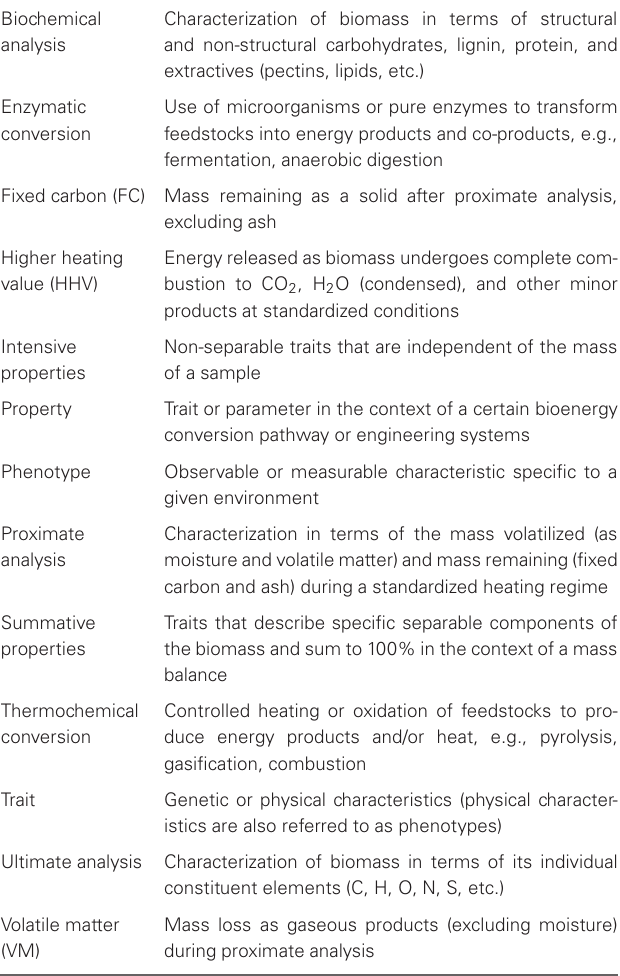
Table 1 | Common terms used in this review in the context of biomass for